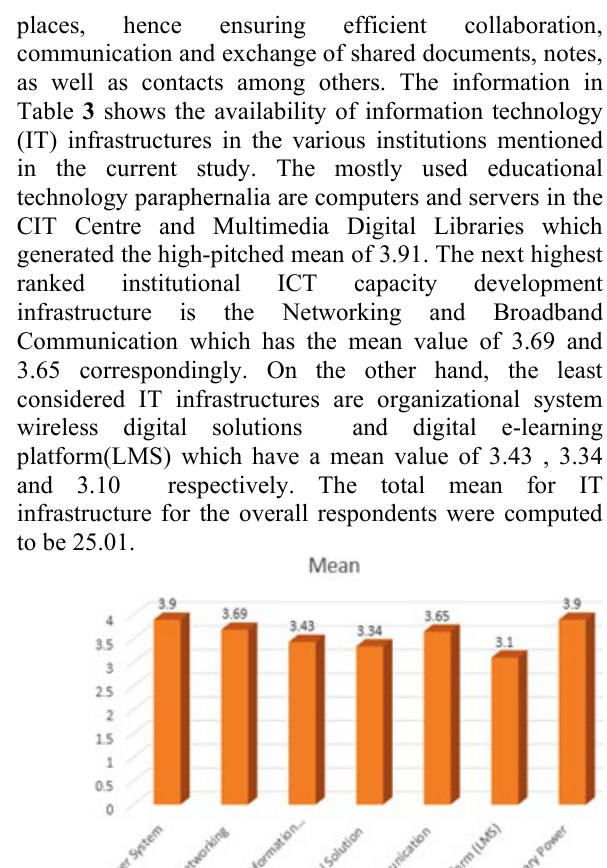
Figure 3. Enterprise Mobile E-Learning Education Implementation using Cloud Internet of Things